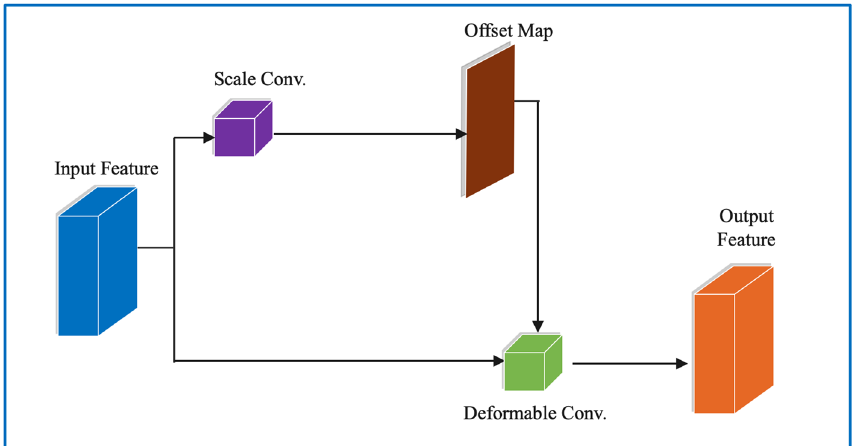
Figure 2. An illustration of a conventional DConv, in which the offsets are obtained directly from the input